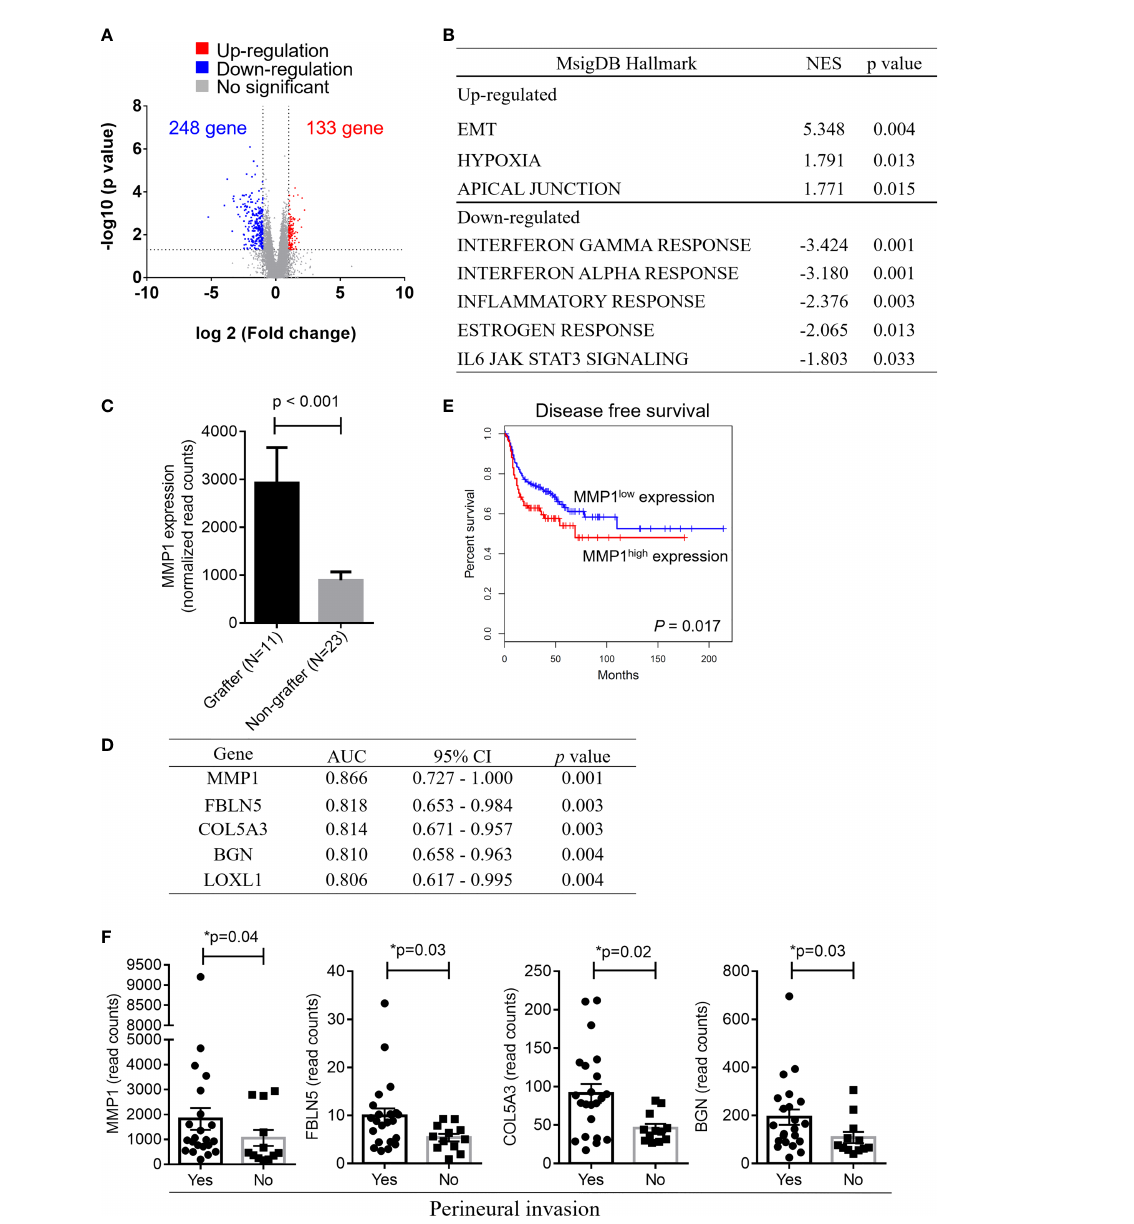
FIGURE 2 | Gene expression signatures in OSCC graftersfor PDXs. Among the49 OSCC patients enrolled inthis study,34 OSCC, including grafters (n = 11)and nongrafters (n = 23), weresubjected to RNA-seq analysis. (A) The volcanoplot displaysDEGs fromRNA-seqdatabetween the grafter and nonengrafter groups. The x-axis shows the log2-fold change values, and the y-axisshows the -log10 p values for the differentially expressed genes. (B) The differentially expressed pathwaysbetween nongrafters andgrafterswere determined byGSEA. (C) A bar chart of MMP1 expression between grafters(n=11) andnongrafters (n=23) byRNA-seq. (D) An AUC ranking table of the top fi ve genes (MMP1, FBLN5, COL5A3, BGN, and LOXL1) with an AUChigher than 0.8 for distinguishinggraftersfrom nongrafters. (E) Kaplan ‐ Meier plot showingthe disease-free survivalfor patient subgroupsstrati fi ed byhighversuslow gene expression of MMP1 amongthe 514 patients in the HNSCC ‐ TCGA dataset. The p values were calculated usinglog ‐ ranktests. (F) The expression ofMMP1, FBLN5, COL5A3, andBGN byRNA-seq analysis inoralcancer patients with or without perineural invasion. The p values were calculatedusing theMann – Whitney U test. The P value < 0.05 indicatedstatistical signi fi cance (*: p <